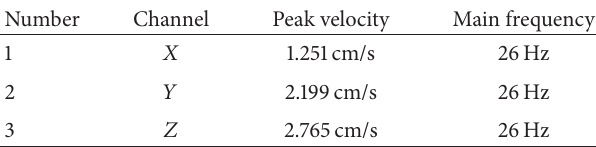
Table 3: Peak velocity and main frequency